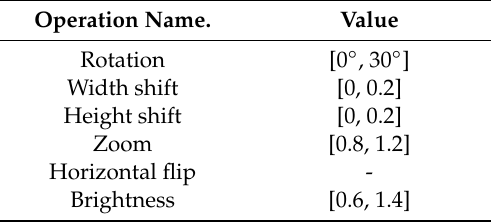
Table 1. Data augmentation